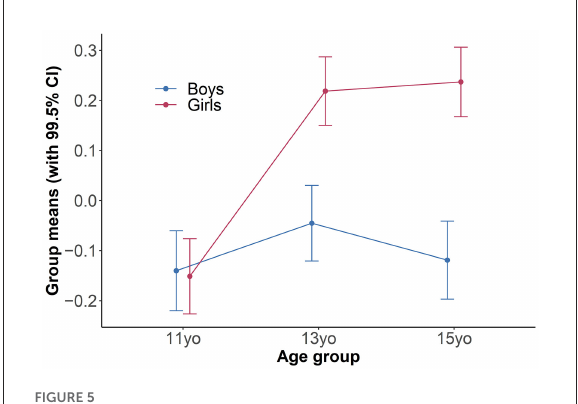
FIGURE5 Latent means of the Social Media Disorder Scale, depending on gender and